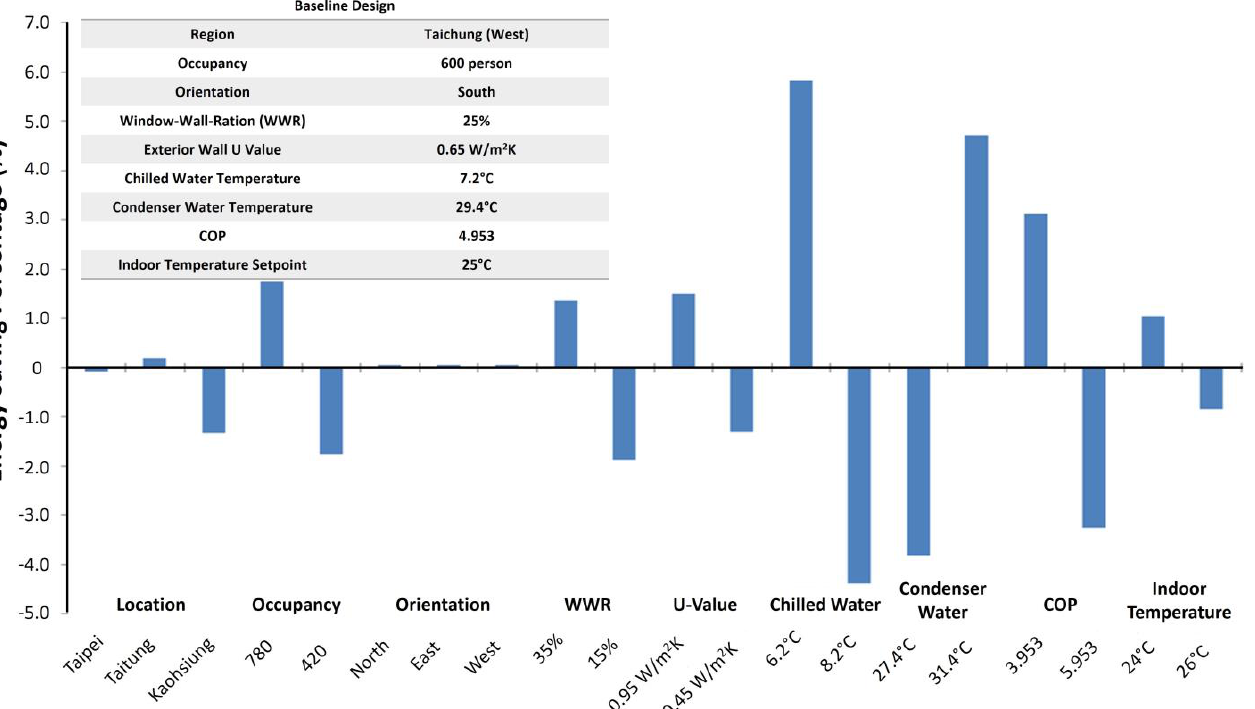
insulation, and shading. Buildings that are well insulated and have proper shading can reduce the amount of energy needed for heating and cooling, regardless of their location. The window-to-wall ratio (WWR) indicates the proportion of a building ’ s window area to its total exterior wall area. The most energy-efficient window-to-wall ratios are around